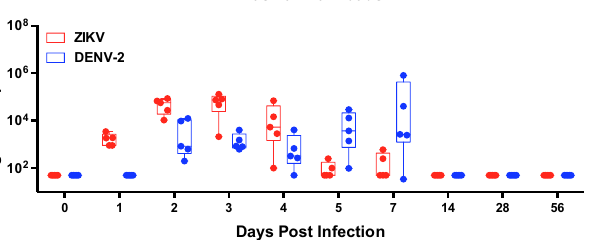
Figure 1. Simultaneous coinfection with ZIKV and DENV-2 does not alter the kinetics of plasma viremia in vivo . The kinetics of ZIKV (red) and DENV-2 (blue) viral loads in plasma of rhesus macaques (n = 5) that were simultaneously coinfected with both viruses at the same site subcutaneously. Error bars represent standard